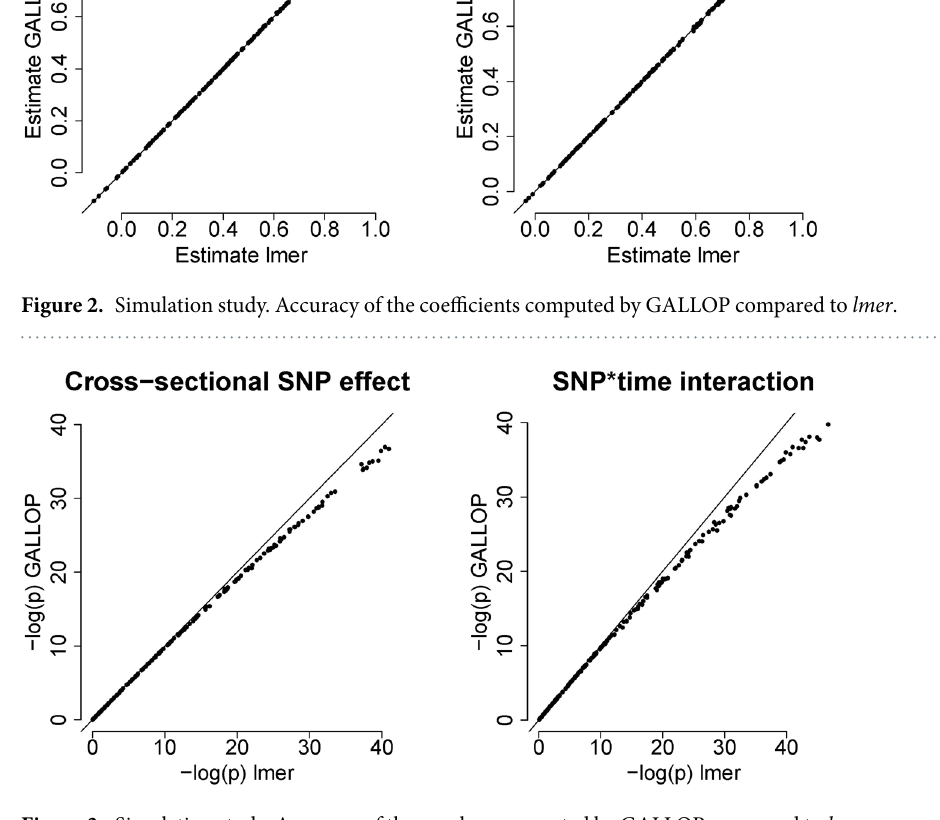
Figure 3. Simulation study. Accuracy of the p-values computed by GALLOP compared to lmer